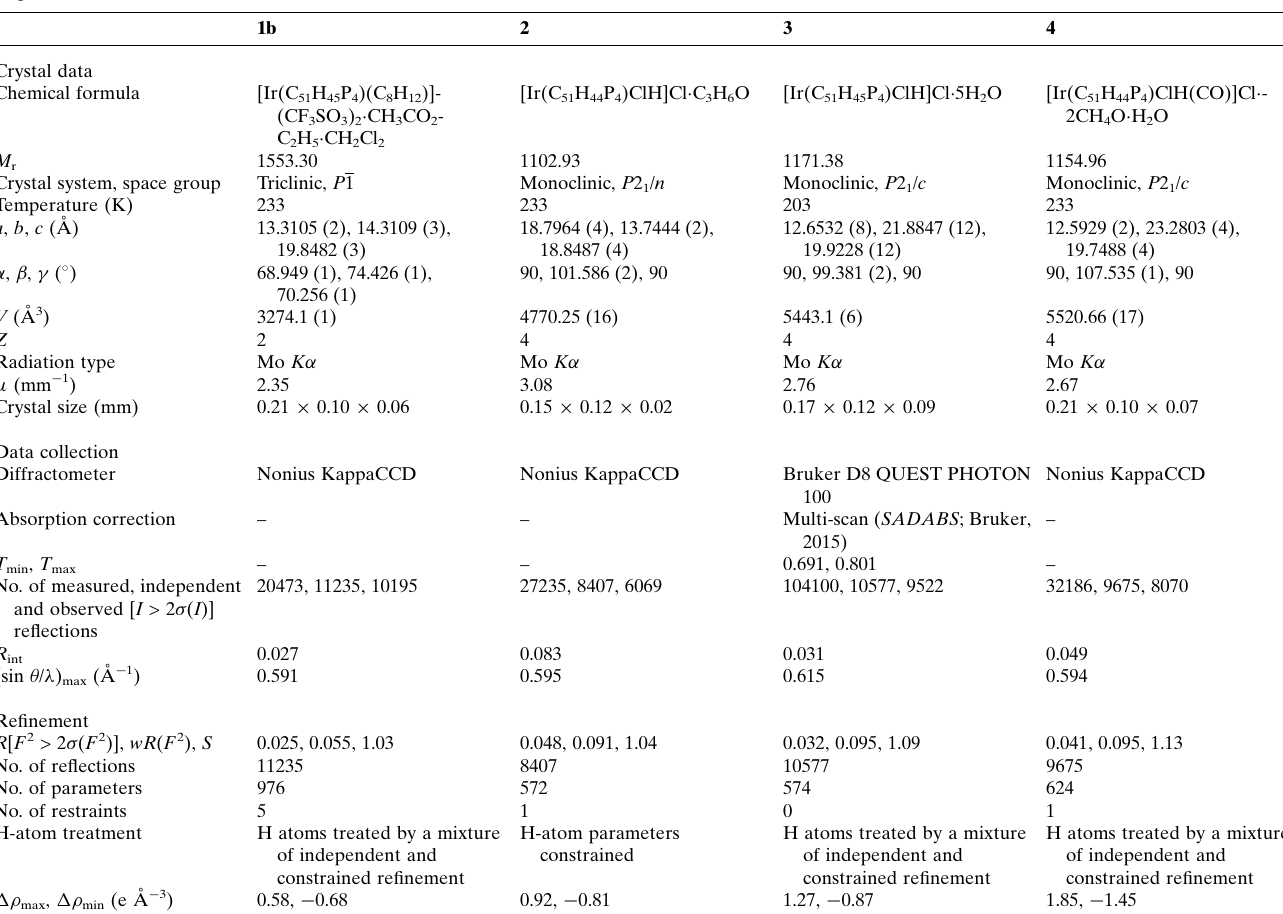
Table 6 Experimental details.